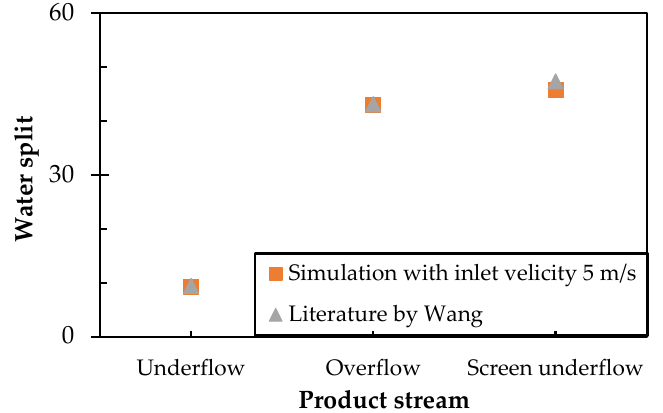
Figure 2. Comparison between the Computational fluid dynamics (CFD) simulation and the litera- ture [14] under the same inlet velocity of 5 m/s.